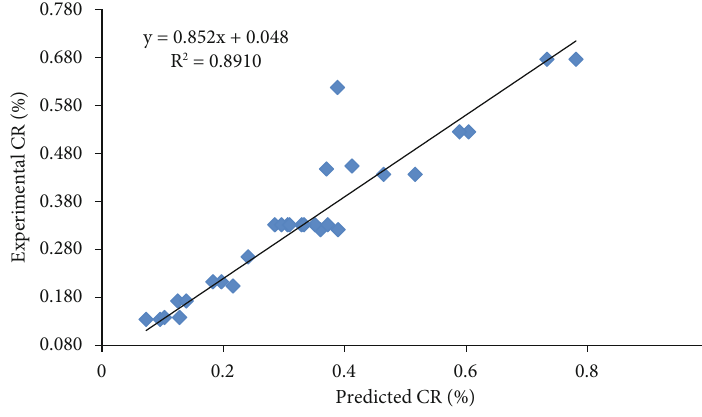
Figure 5: Corrosion rate experimental versus predicted Table 7: Type III ANOVA result for corrosion rate.